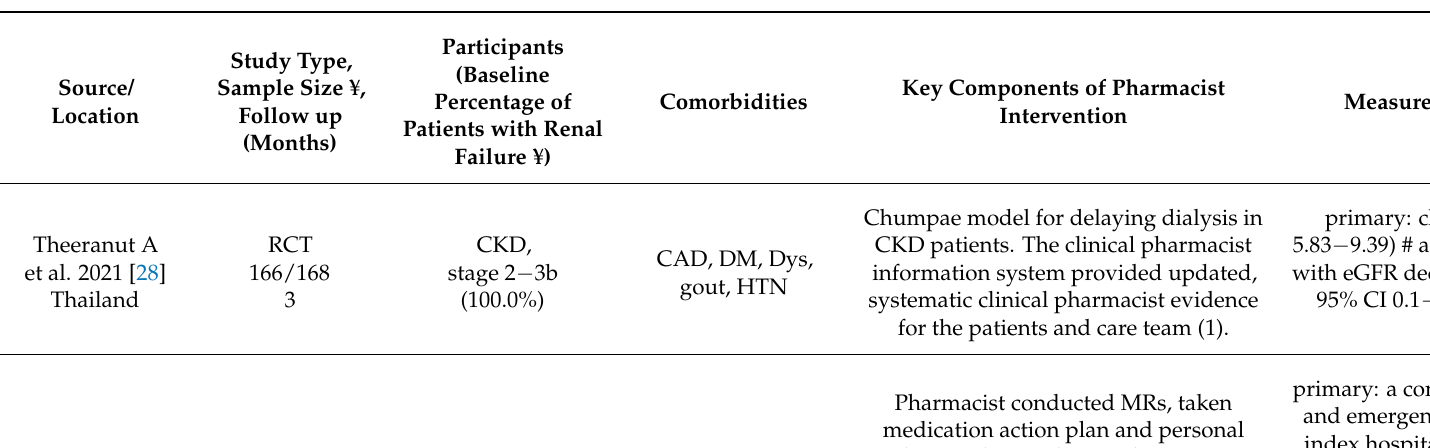
Measured Outcomes (Intervention vs. Usual